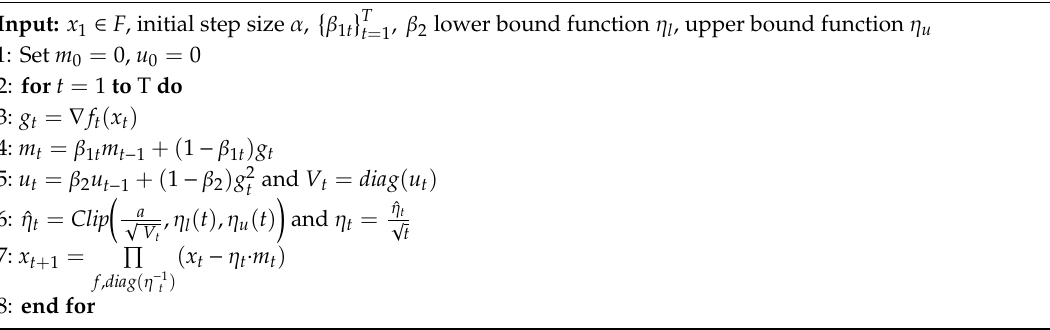
Algorithm 3. The AdaBound